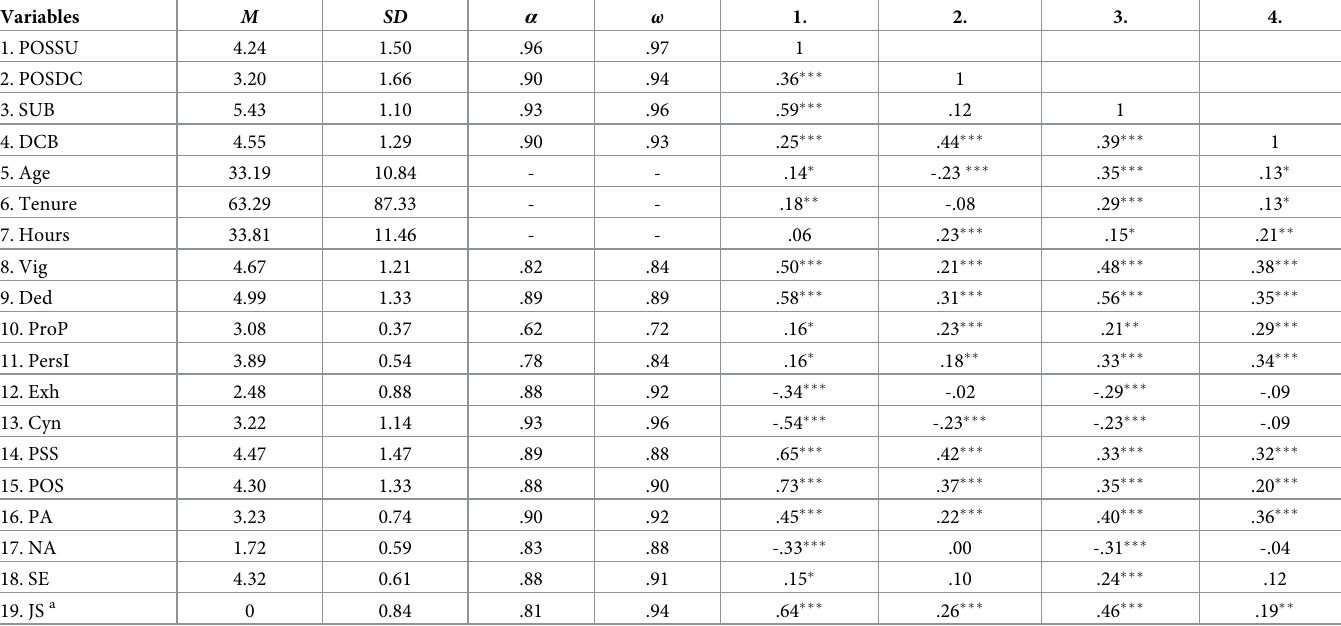
Table 4. Descriptive statistics and inter-correlations for Study 2 (N = 243).